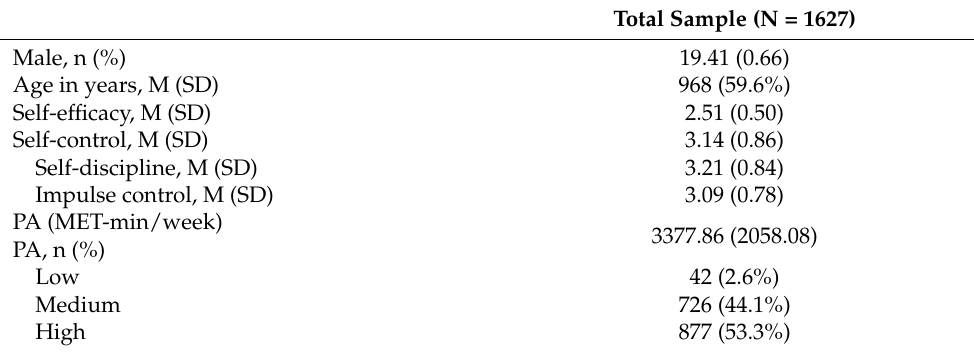
Table 2. Descriptive data for main variables.